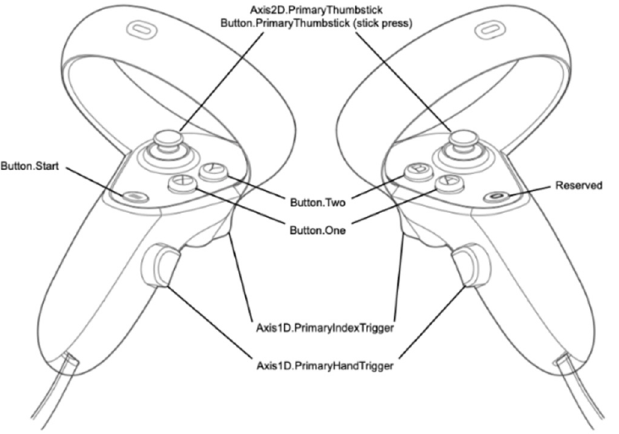
Figure 2. OVRInput API in Unity3D for Touch controller. (source: Oculus Quest controller